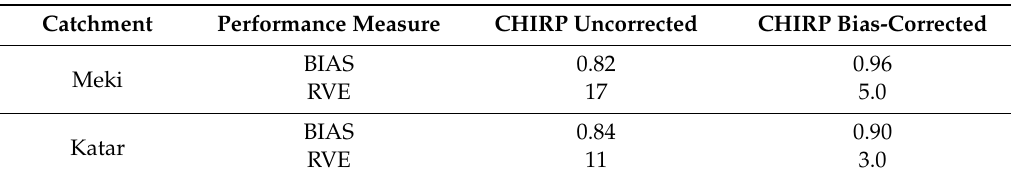
Table 8. Comparison of rainfall and streamflow di ff erences between uncorrected and bias-corrected CHIRP satellites against gauge-based datasets from